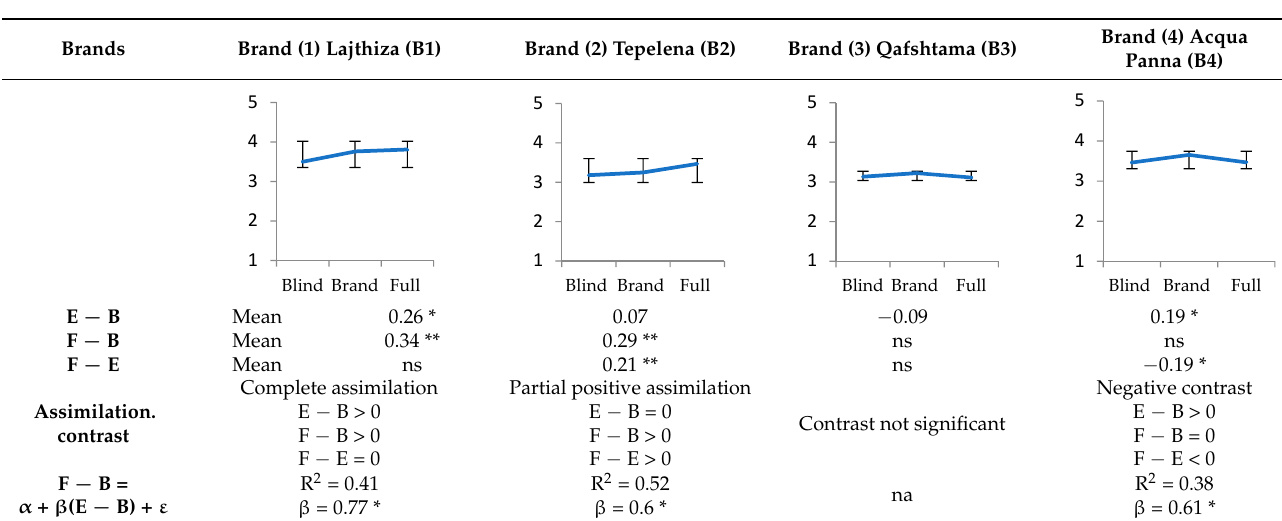
Table 2. Brand equity analysis through disconfirmation of expectations indicators.